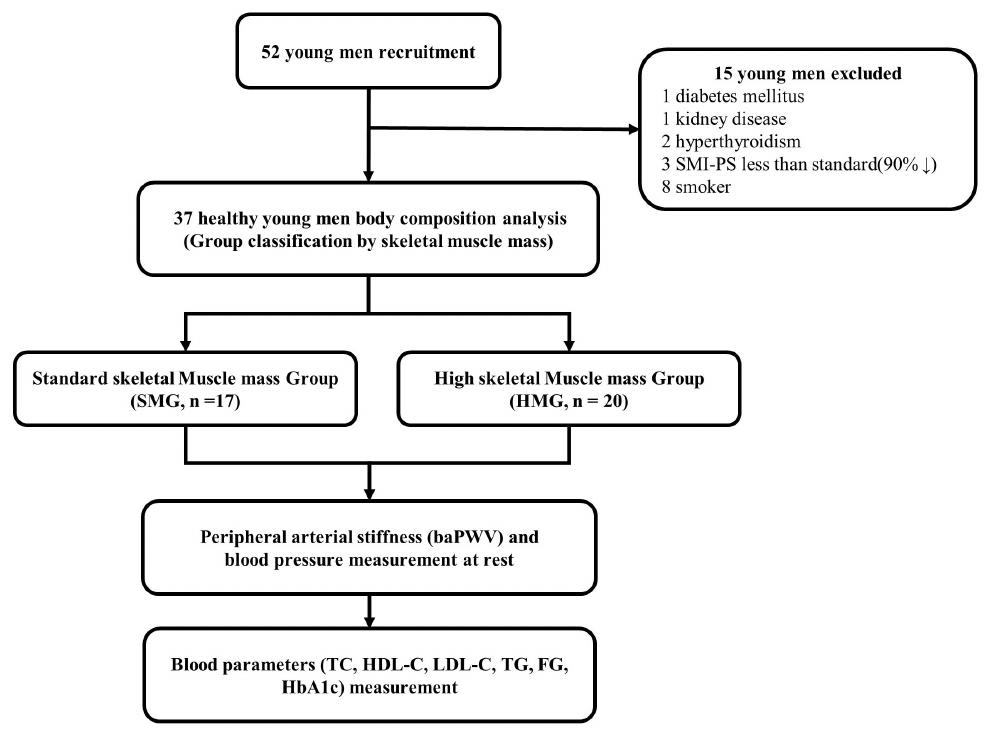
Fig. 1. Schematic flow chart.